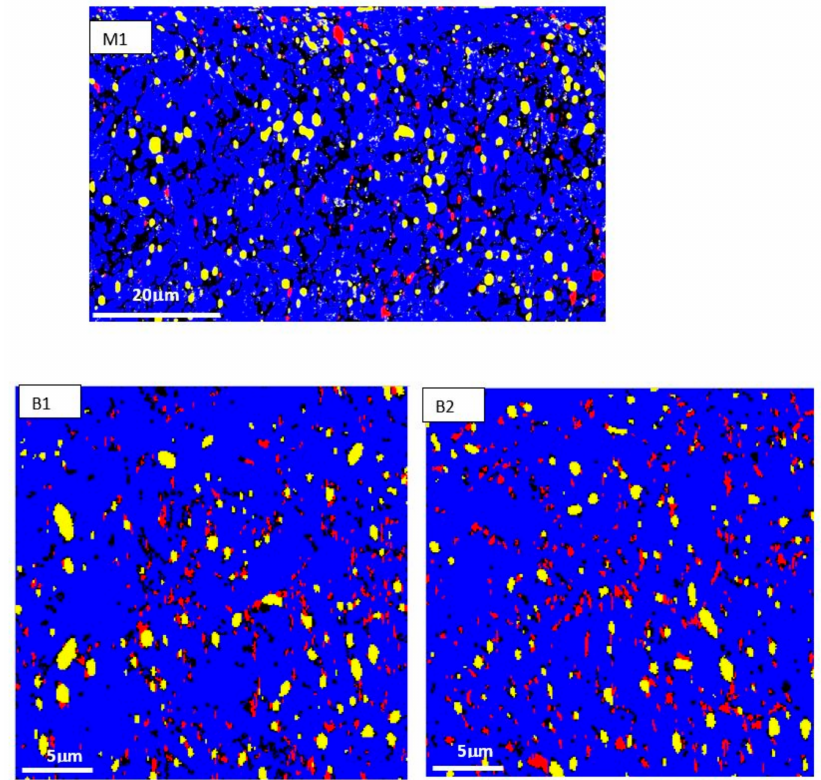
Figure 2. Electron backscatter di ff raction (EBSD) phase fractions of bainitic ( B1 , B2 ) and martensitic ( M1 )